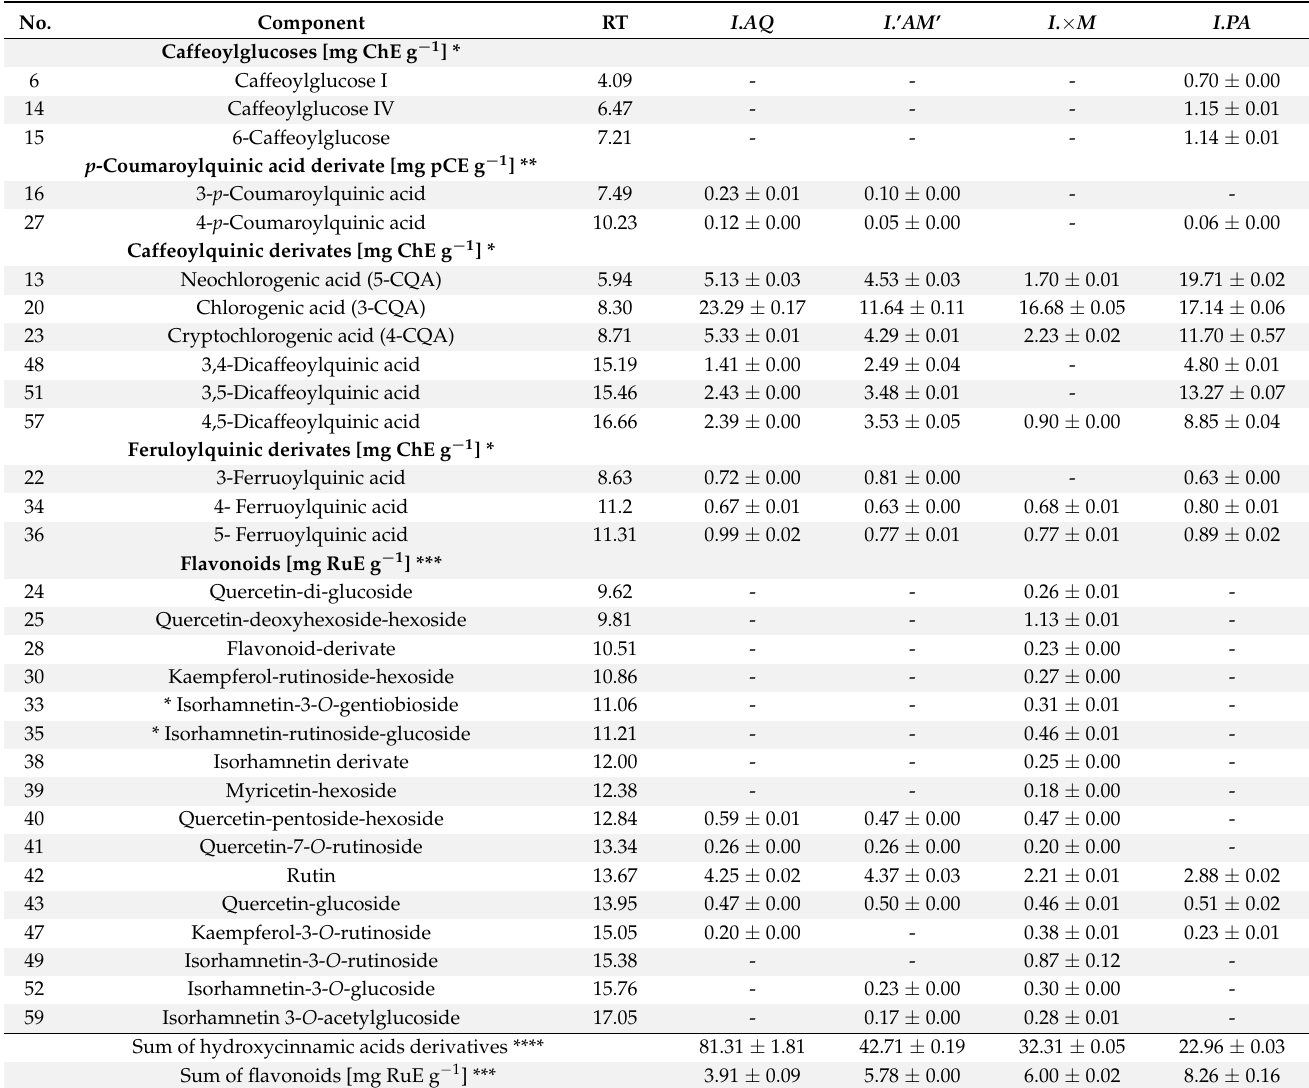
Table 3. Quantification of polyphenols in Ilex leaves water extracts (average from three experiments).